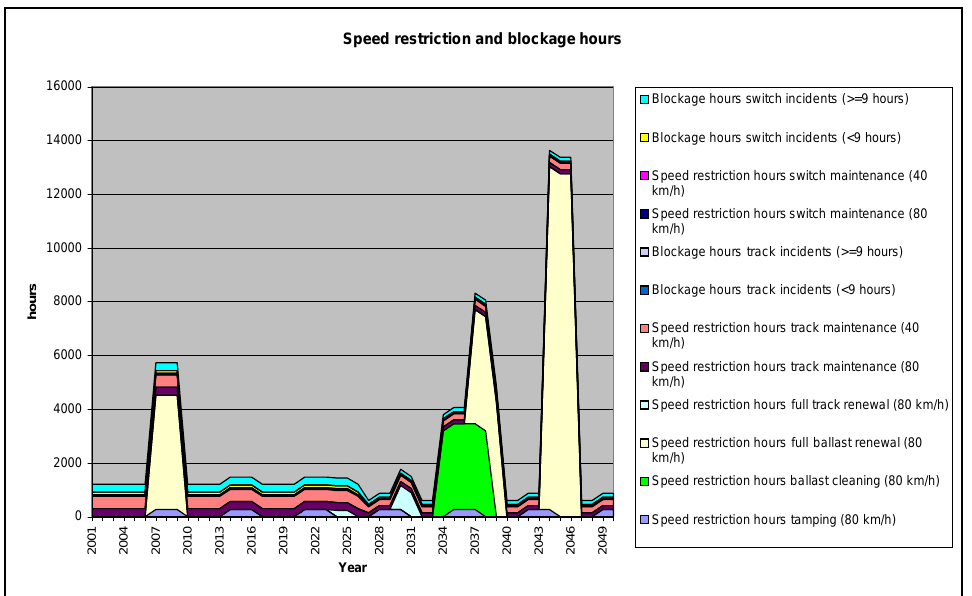
Figure 5. Planned and unplanned disruption, intermediate result after step